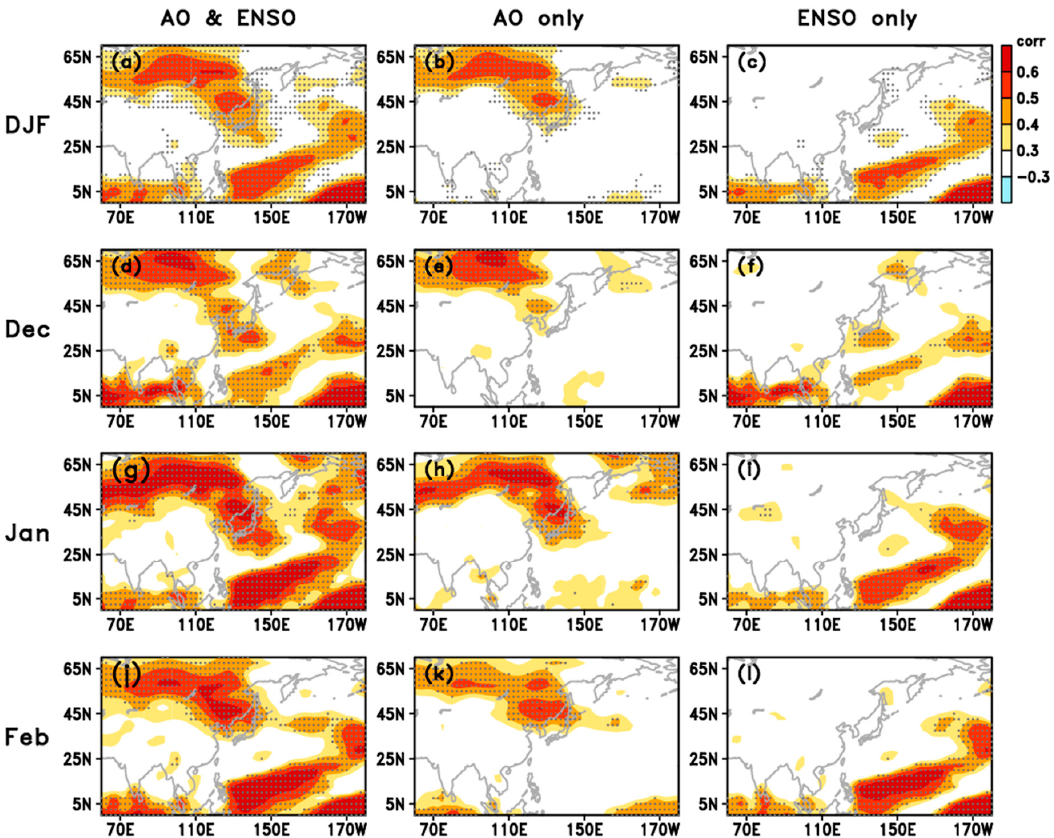
Figure 8. Correlation maps between observational SAT and SAT reconstructed from multiple regression based on (left column) AO and ENSO in ( a ) DJF mean, ( d ) December, ( g ), January, and ( j ) February. Center columns are the same as left column, but for SAT regressed on AO-only in ( b ) DJF mean, ( e ) December, ( h ), January, and ( k ) February. Right columns are the same as left column, but for SAT regression on ENSO-only in ( c ) DJF mean, ( f ) December, ( i ), January, and ( l ) February. Gray dots denote grid points which satisfy 95% confidence level through the two-tailed Student’s T-test.